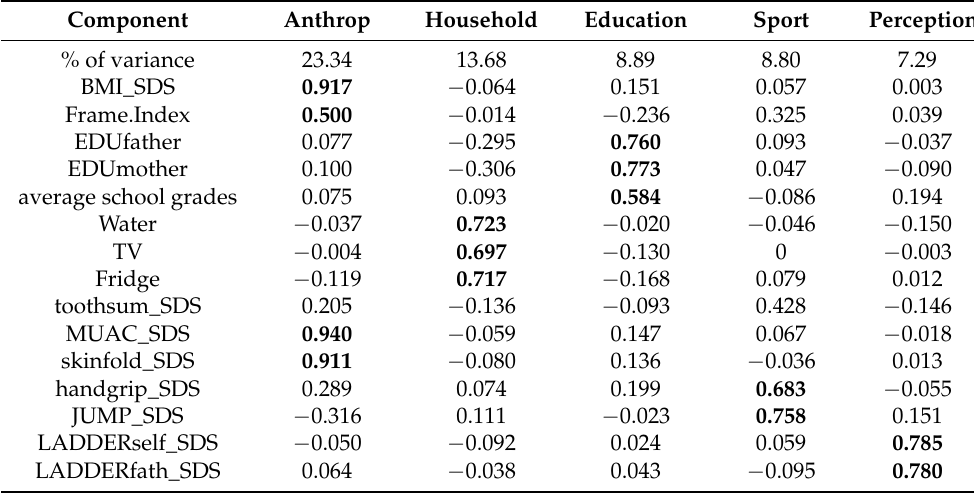
Table 5. Rotated component matrix of Principal Component Analysis (PCA) after excluding age, height, weight, and elbow breadth. The remaining variables can be separated into five major Components, Varimax-Rotation, Eigenvalues > 0.5 are